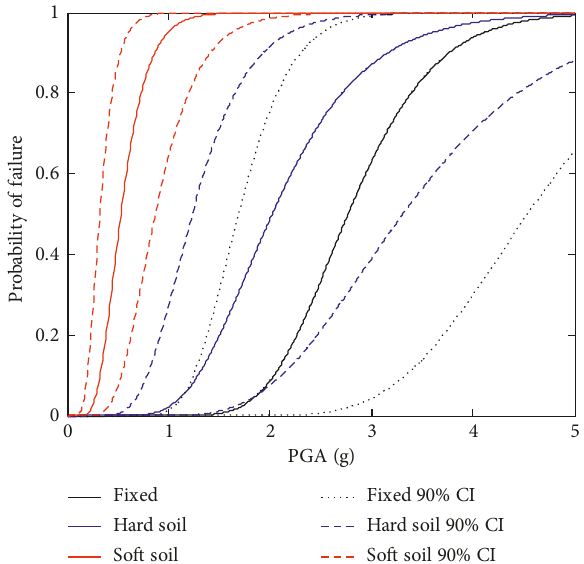
Figure 13: Seismic fragility curves of median and 90% CI: fixed, hard soil, and soft soil (case